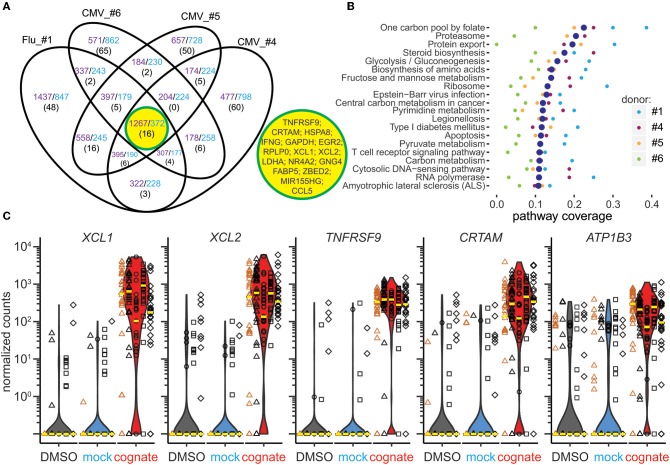
Combined gene and pathway analysis of Flu MP58−66- and CMVpp65495−503-responsive CD8+ T cells. (A) Venn diagram of overlapping genes upregulated (purple) or downregulated (blue) in Flu MP58−66-directed (donor #1) or CMVpp65495−503-directed CD8+ T cells (donors #4–6) following stimulation with the cognate peptide relative to control stimuli. The number of genes belonging to the top 100 differentially expressed genes in each individual is shown in parenthesis. Sixteen genes were shared between all individuals, as shown in the central yellow circle. (B) Top 20 KEGG pathways identified based on the differentially expressed genes in individual donors following stimulation with cognate peptide relative to control stimuli. The pathways showing significant enrichment for these genes in at least one donor were included in the analysis and were ranked based on the median pathway coverage (large blue dots) for all donors. (C) Scatter/violin plots showing normalized counts of the five genes that best separated the cognate peptide-stimulated and control-stimulated cells in antigen-directed CD8+ T cells incubated with cognate peptide (red violins) relative to solvent (black) or mock peptide (blue) in the presence of autologous PBMCs (black symbols) or K562/A*0201 (orange symbols). The y-axis represents the normalized read counts for individual Flu MP58−66-specific cells from donor #1 (triangles) or CMVpp65495−503-specific cells from donors #4 (circles), #5 (squares), and #6 (diamonds). The median values for individual donors and conditions are shown as yellow lines. Similar cell numbers were analyzed per condition for each donor, and data comprise counts for 148 cells incubated with DMSO, 152 cells incubated with mock peptide, and 143 cells stimulated with the cognate peptide.